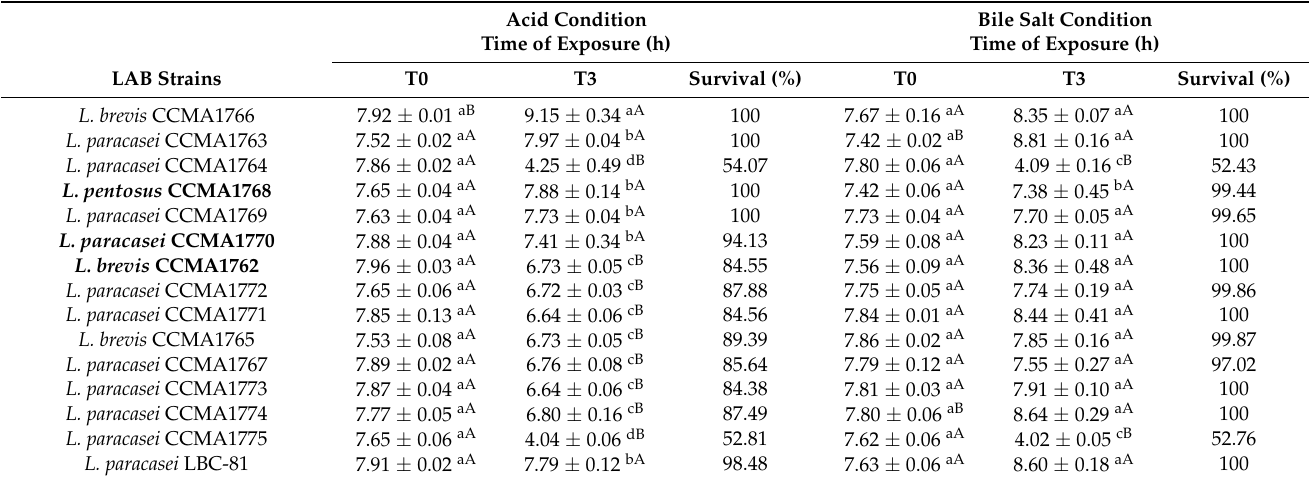
Results Log CFU mL − 1 are expressed as mean ± SD, determined in duplicate. Mean values of different letters, lower case in columns and uppercase in rows differ significantly ( p < 0.05) by the Scott–Knott test. Time of exposure: T0 : Initial mean count; T3 : Mean count after 3 h. Survival at pH 2 (%) or bile salt (%) = Final viable count (Log CFU mL − 1 )/Initial viable count (log CFU mL − 1 )) × 100. Strains showing potential properties as probiotics used during the simulated digestion are bolded.